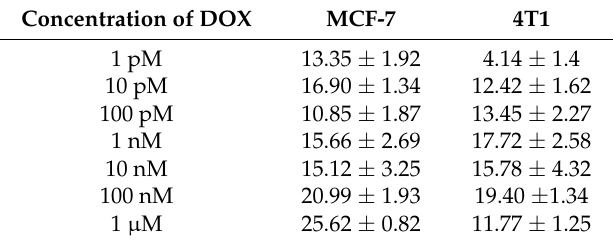
Table 1. Enhancement of cytotoxicity (%) for DOX (Doxorubicin)-loaded CMCA (Citrate-modified carbonate apatite) NPs